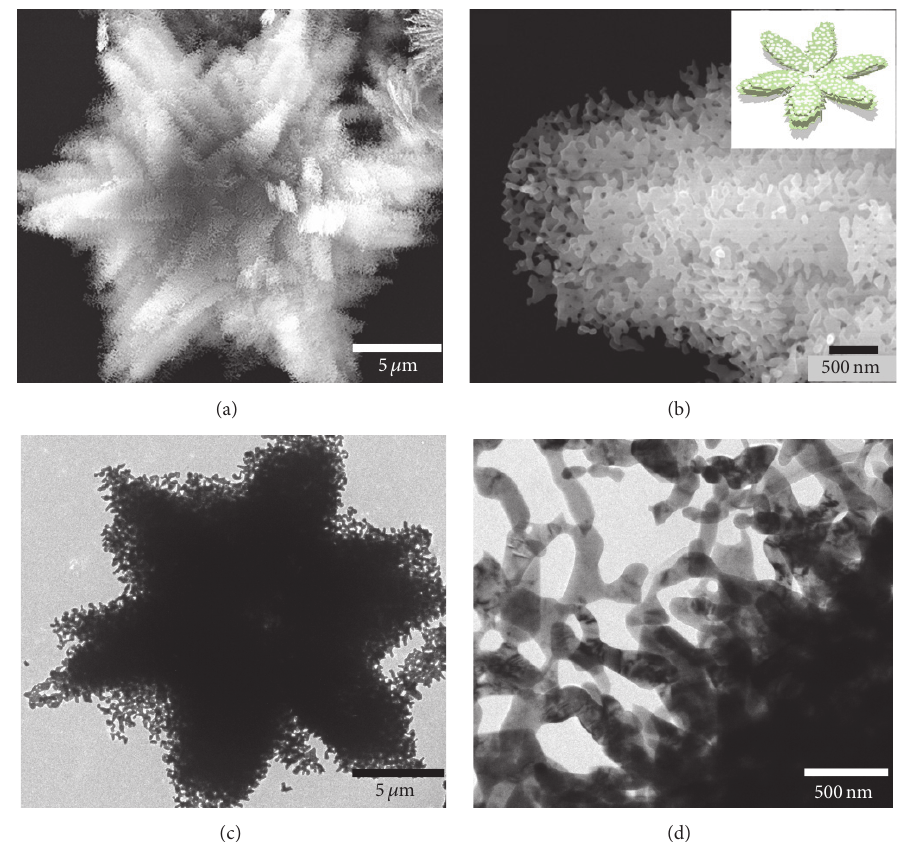
Figure 1: (a) Low- and (b) high-magnification SEM images and (c), (d) TEM photographs of the snowflake-shaped architectures. Inset in (b) is an illustration of the nanostructure.